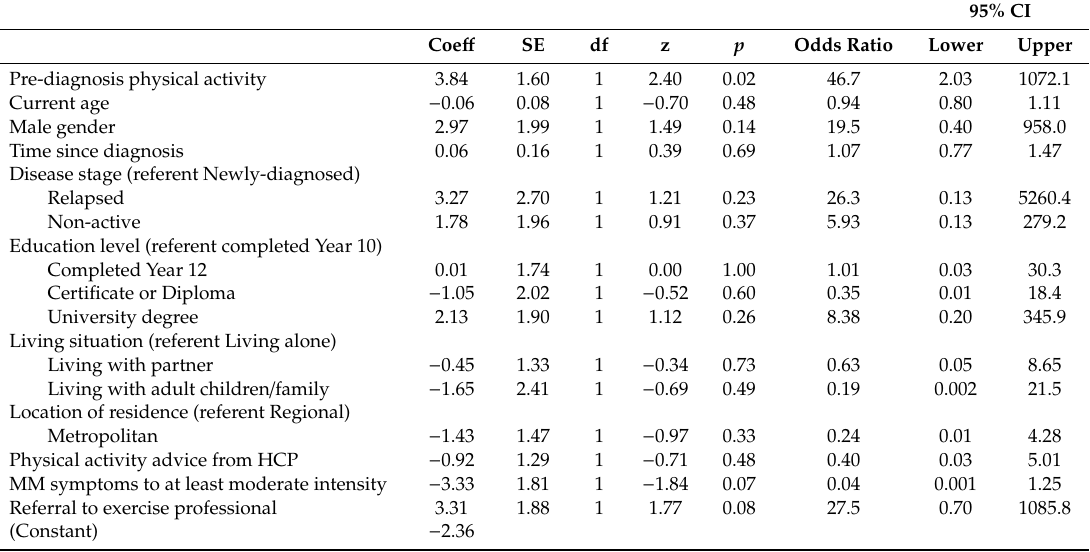
Table 2. Logistic regression predicting the likelihood of participating in su ffi cient physical activity among people with multiple myeloma ( n =